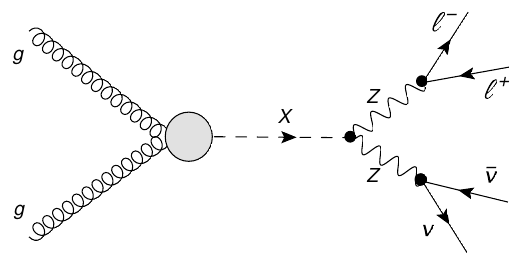
Figure 1 . Leading order Feynman diagram for the production of a generic resonance X via gluon- gluon fusion decaying to the ZZ (cid:12)nal